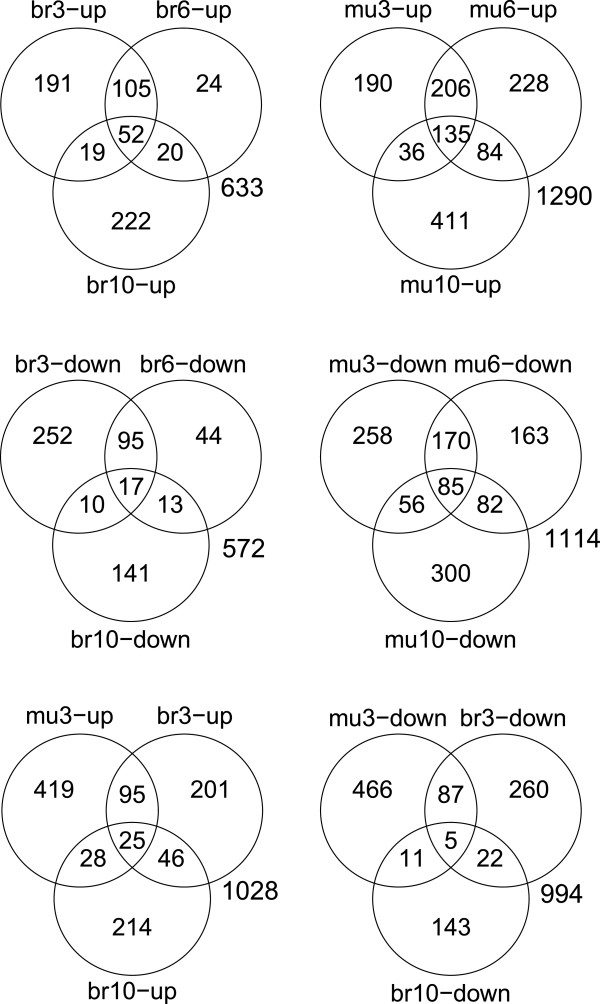
Venn diagram of treatment specific hypoxia induced gene groups in Spalax. Brain/muscle differential expression at 3% 6 hrs, 6% 6 hrs, 10% 44 hrs hypoxia, are denoted br3/mu3, br6/mu6, br10/mu10, respectively. Numbers inside closed regions represent counts of genes which are found to be differentially expressed as compared to normoxia. The numbers beside each diagram represent the union of the sets of differentially expressed genes.